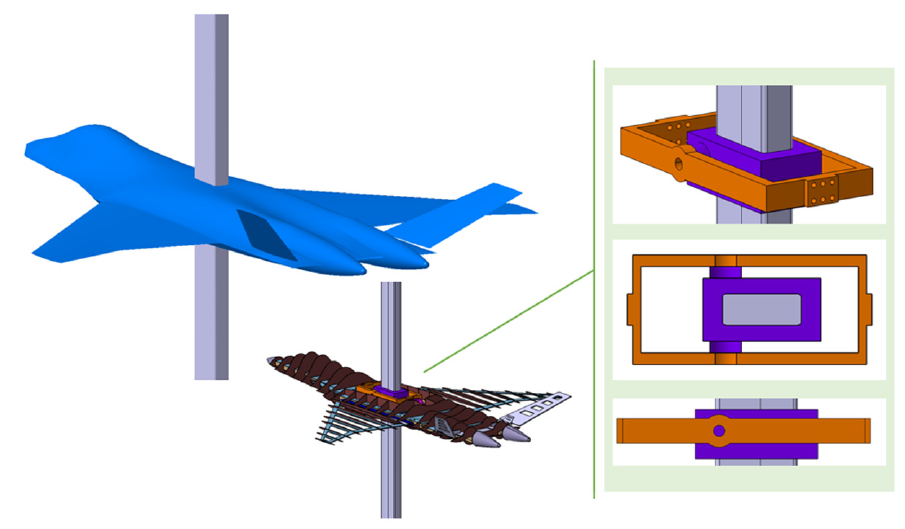
Figure 9. The aircraft model installed with the wind tunnel test support system.